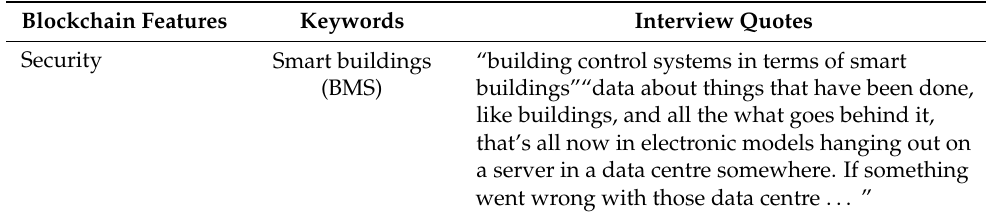
Table 11. Interview quotes in relation to the BCDT Non-functional